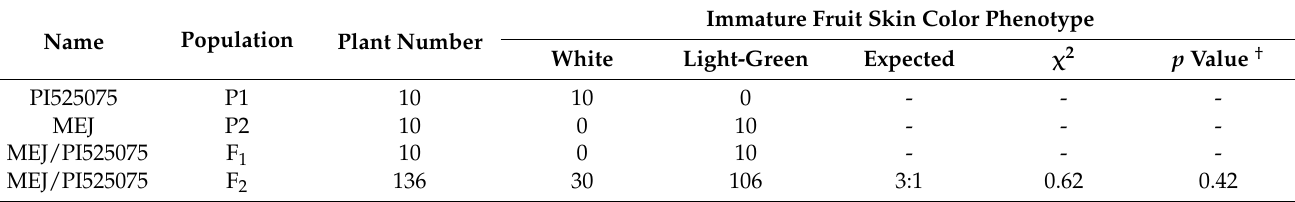
Figure 1. Phenotypic analysis of immature fruit skin color of immature cucumber fruits. ( a) Fruit phenotype of PI525075 (P1), MEJ/PI525075 (F 1 ) and MEJ (P2); ( b ) fruit phenotype of F 2 derived from a cross between MEJ and PI525075. Table 1. Segregation analysis of immature fruit skin color phenotype in cucumber.